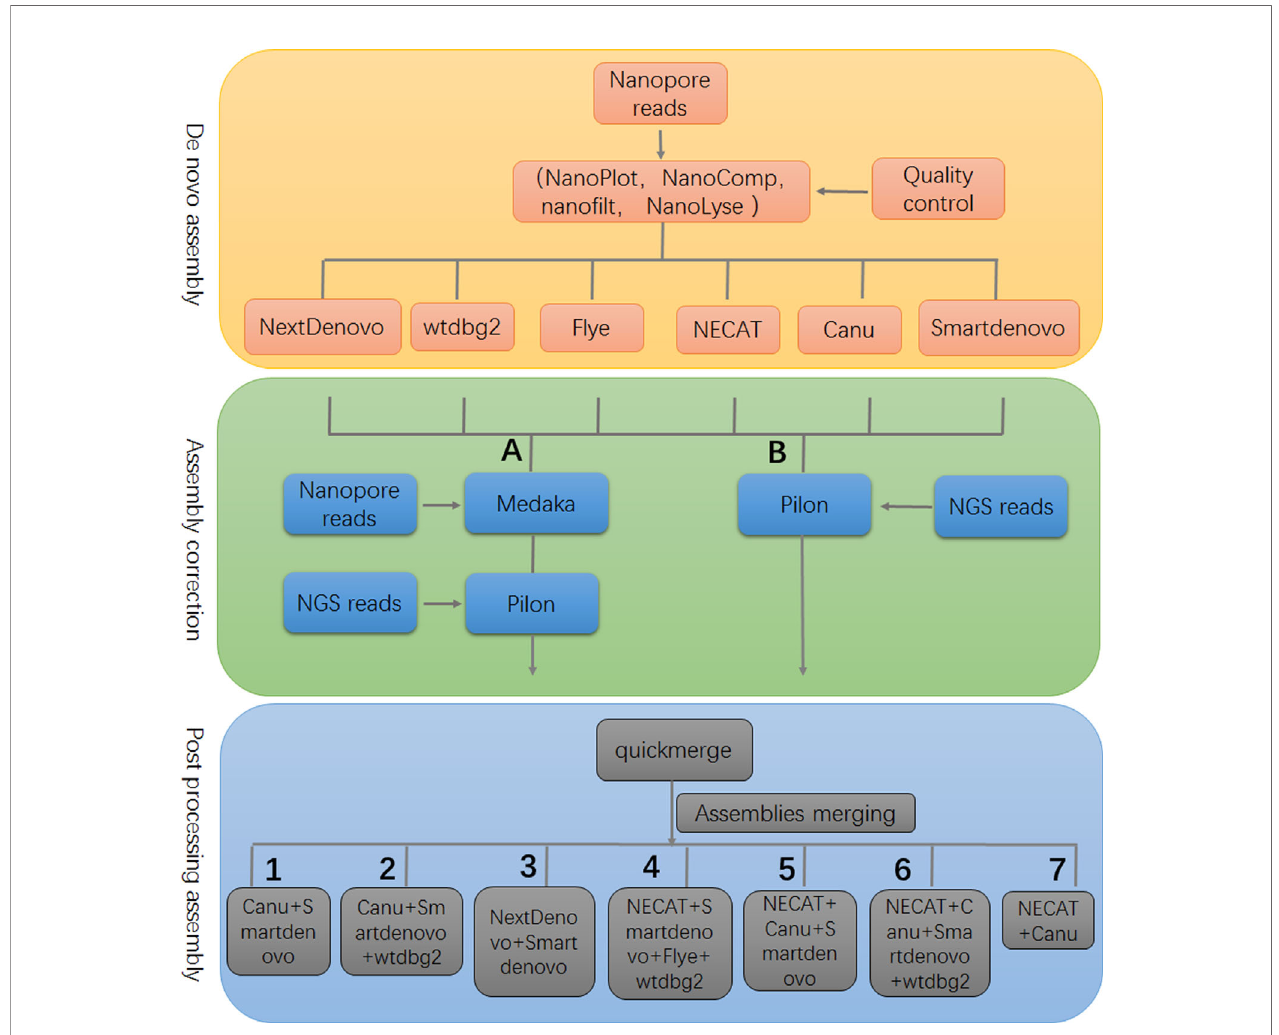
FIGURE 4 | The framework of genome assembly. In the stage of assembly correction, either strategy (A) or (B) could achieve similar results. There were seven optional post-processing strategies that are recommended to produce a high quality